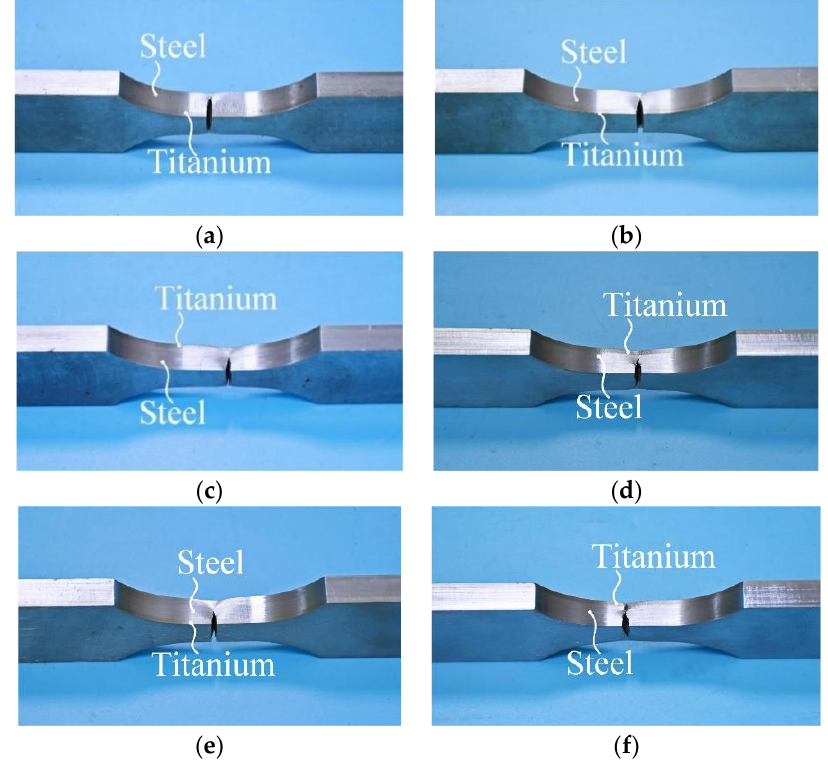
Figure 8. Failure modes that were observed in fatigue tests: ( a ) HCF-EB-HBS-7 (nominal maximum stress: 400 MPa); ( b ) HCF-HR-LBS-5 (nominal maximum stress: 370 MPa); ( c ) HCF-HR-LBS-12 (nominal maximum stress: 390 MPa); ( d ) HCF-HR-HBS-5 (nominal maximum stress: 430 MPa); ( e ) HCF-HR-HBS-14 (nominal maximum stress: 422.5 MPa); and ( f ) HCF-HR-HBS-8 (nominal maxi- mum stress: 430